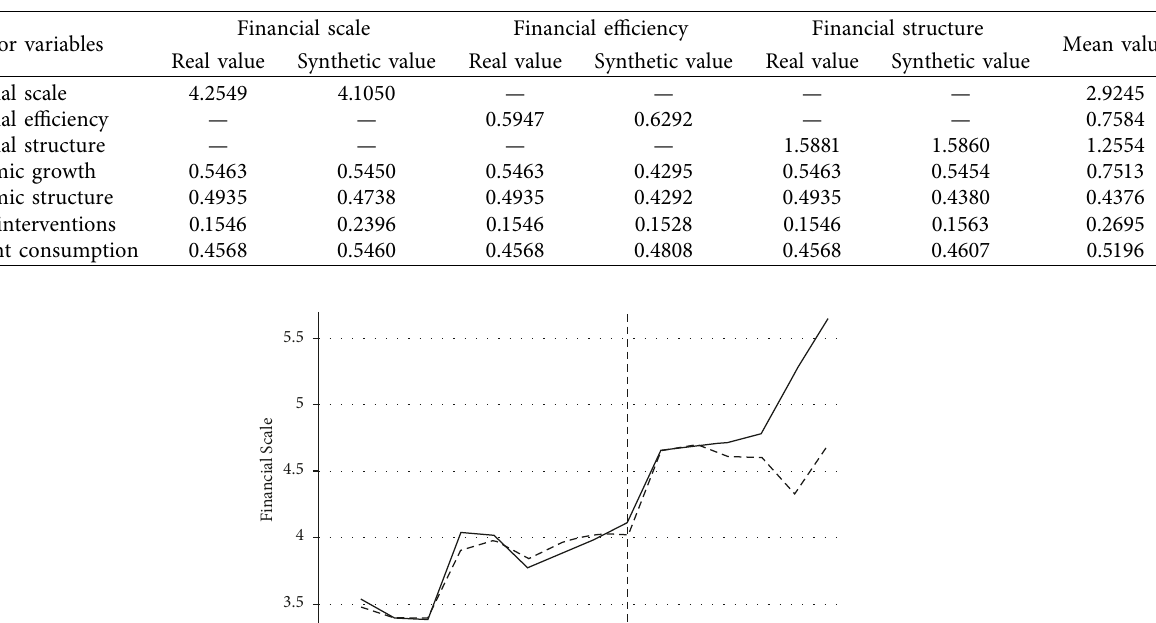
Table 4: Comparison of real and synthetic values of predictor variables.